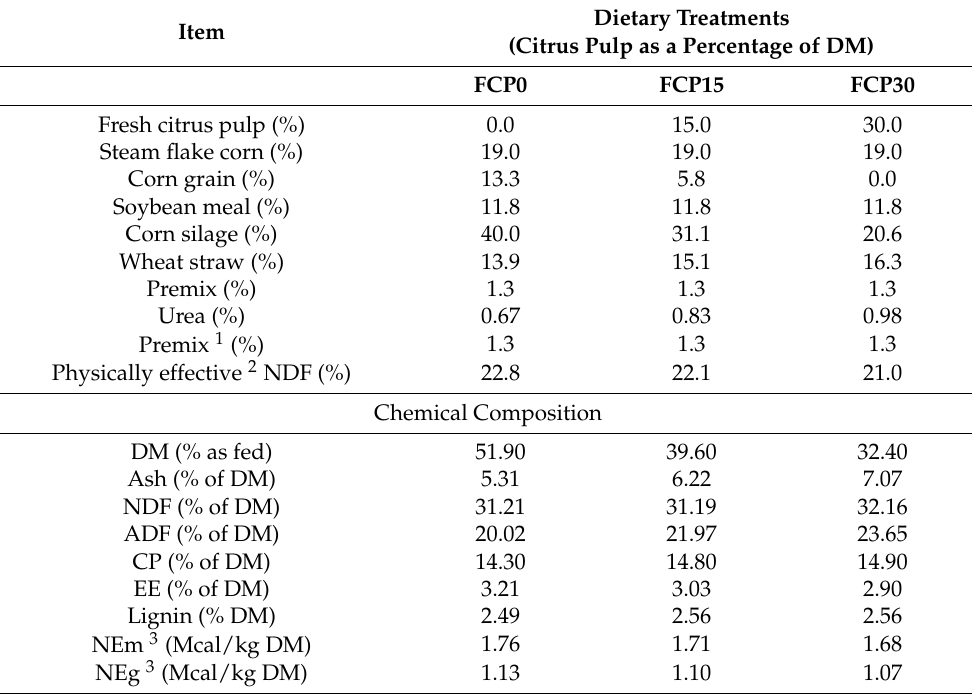
Table 1. Feed ingredients and chemical composition of the